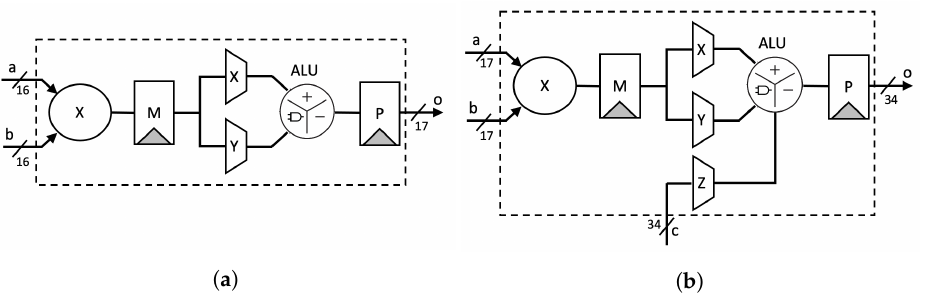
Figure 2. Digital signal processor (DSP) utilization setup: ( a ) 16-bit multiplier; ( b ) 17-bit multiply-accumulate.